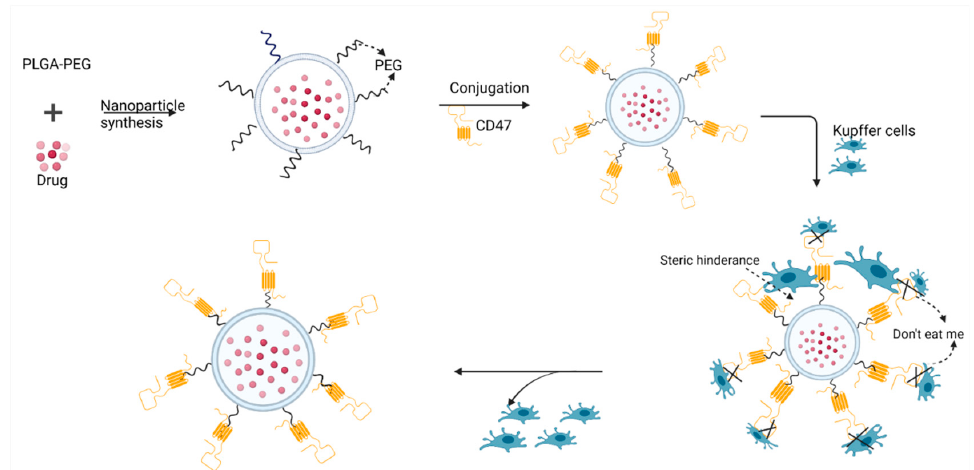
Figure 4. Preparation of a PLGA-PEG nanoparticle loaded with drug molecules and coated with CD47 peptides to prevent phagocytosis by Kupffer cells. Created with BioRender.com.Accessed 30 January 2022